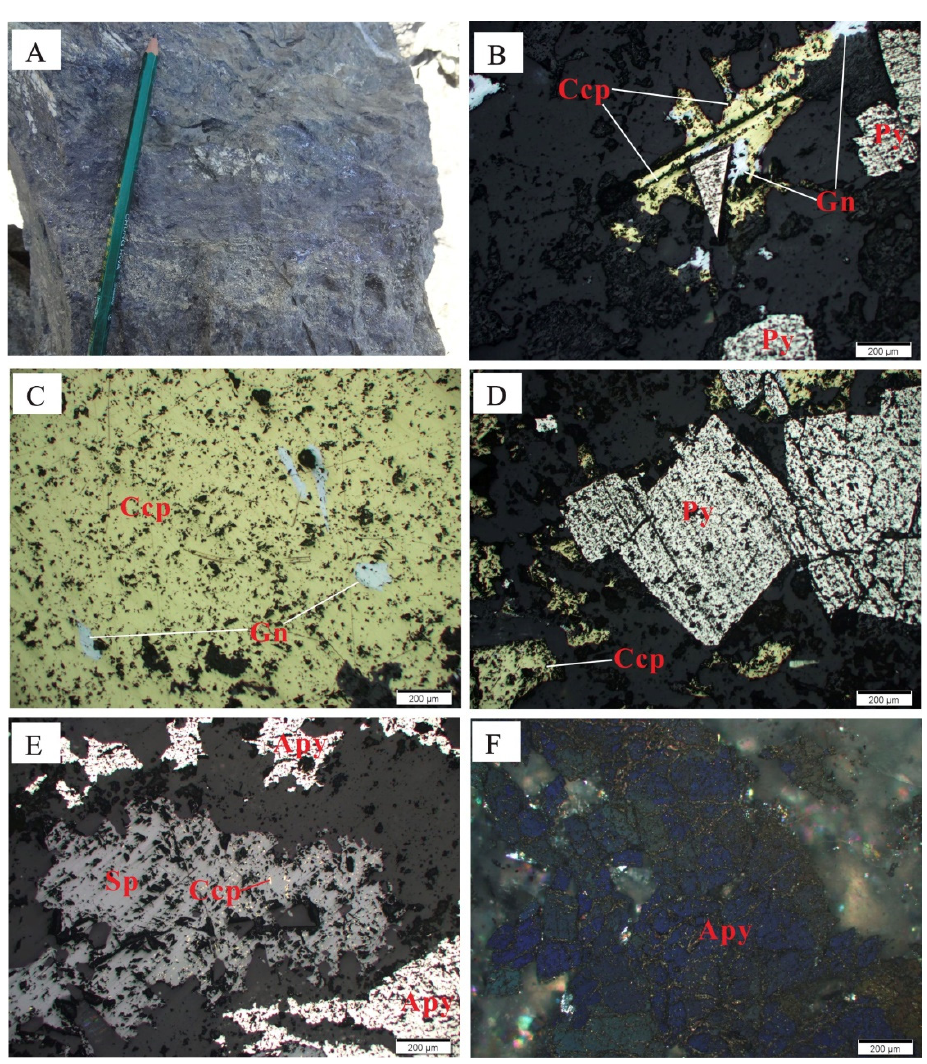
Figure 5. Ore samples and micrographs of the Qiyimuchang deposit. ( A )—Massive ore; ( B )—Galena irregularly distributed on the edge of pyrite, metasomatizing and dissolving pyrite(single polarized reflected light); ( C )—Galena remaining as an island in chalcopyrite and is metasomatized by chalcopyrite to form a residual structure(single polarized reflected light); ( D )—Pyrite presenting pseudocrystalline structure of arsenopyrite after replacing arsenopyrite(single polarized reflected light); ( E )—Emulsion droplets of chalcopyrite in the matrix of sphalerite that show an exsolution structure (single polarized reflected light); ( F )—Arsenopyrite in a crushed structure(orthogonally polarized reflected light).